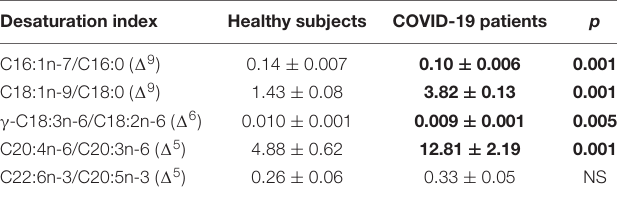
TABLE 5 | Indirect desaturation indexes of the desaturases in the total fatty acids from healthy subjects and COVID-19